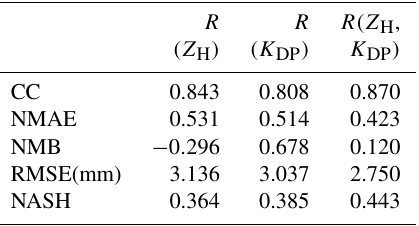
Table 4. Verification of the radar-based rainfall 1h accumulation products of Italy. Z H is not corrected for